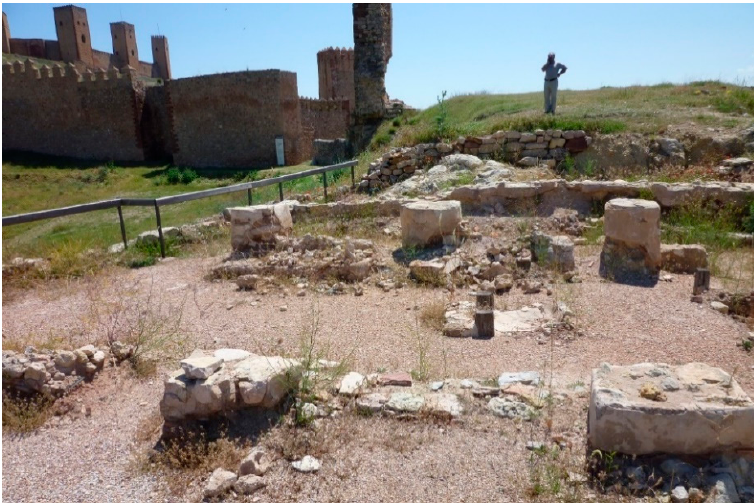
Figure 1. General view of the Synagogue of Molina de Aragón archeological site. Author’s photo.